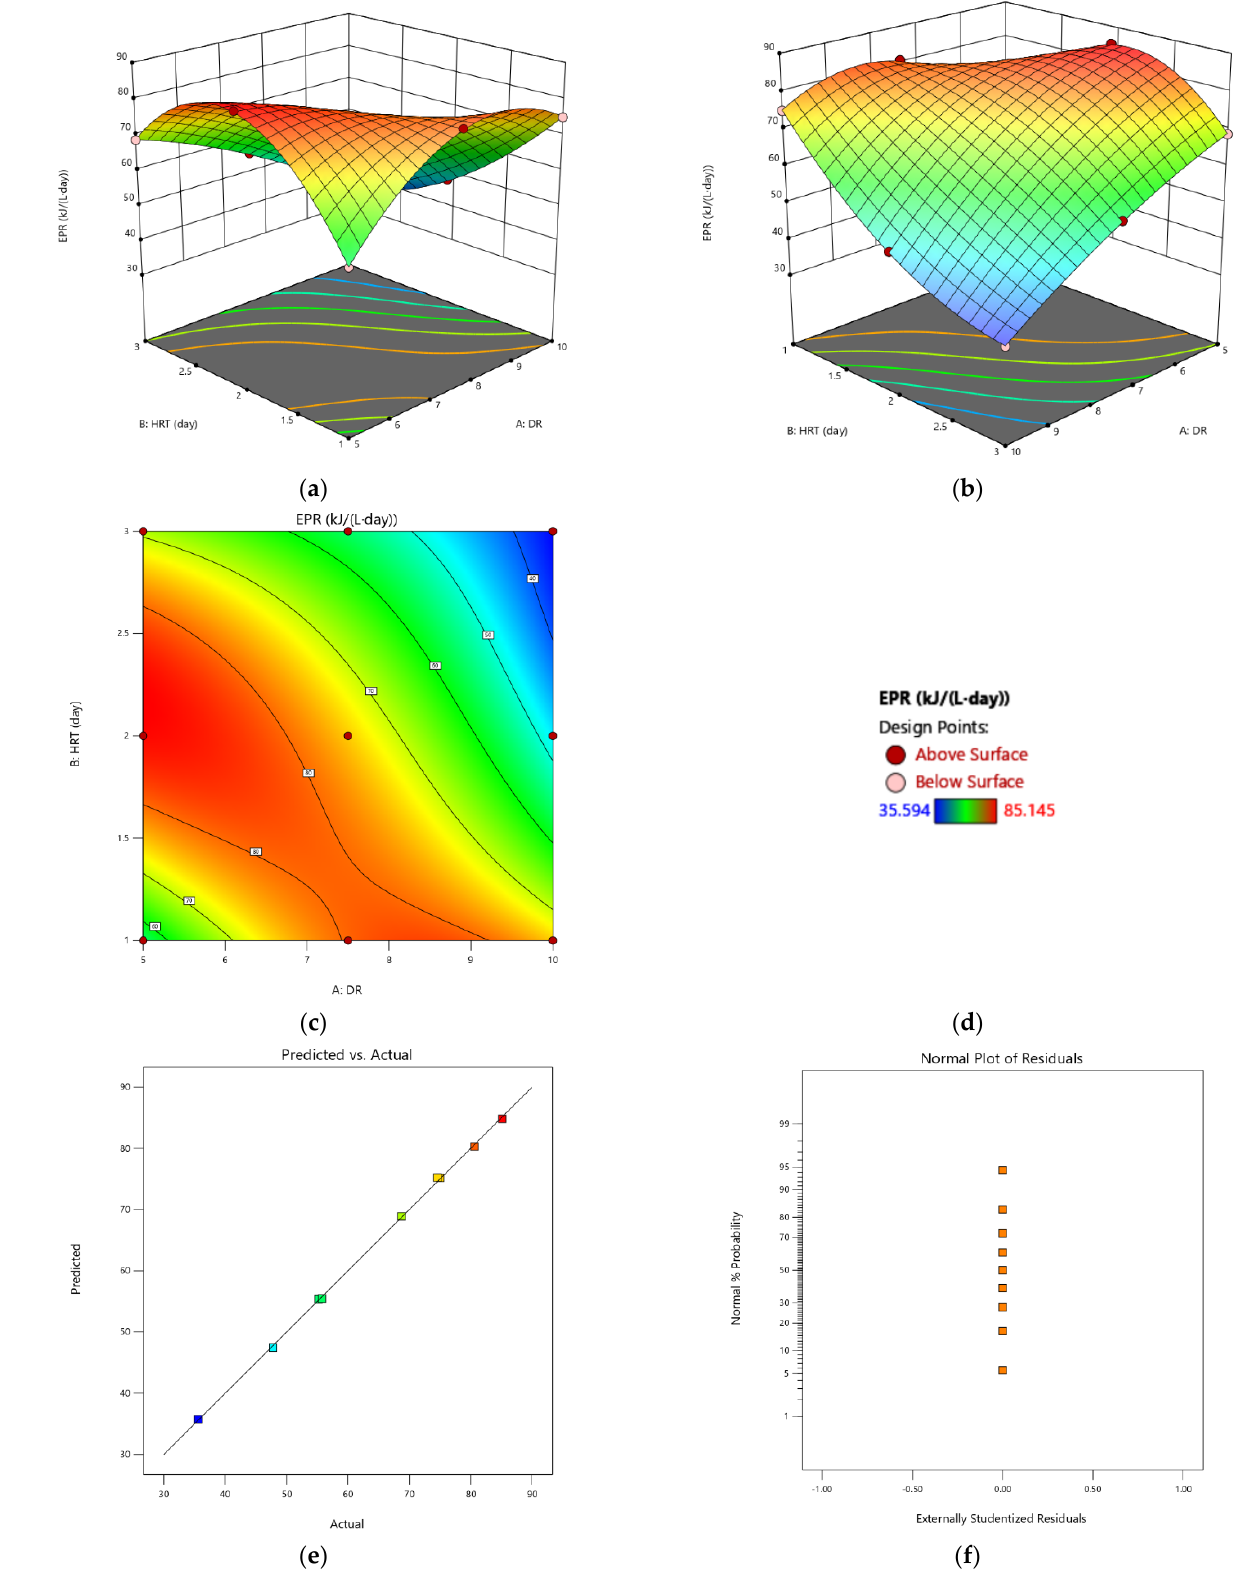
Figure 7. Interactive effect of DR and HRT on EPR: ( a , b ) 3D response surface; ( c ) contour plots; ( d ) color legend; ( e ) plot of actual vs. predicted values; ( f ) normal plot of